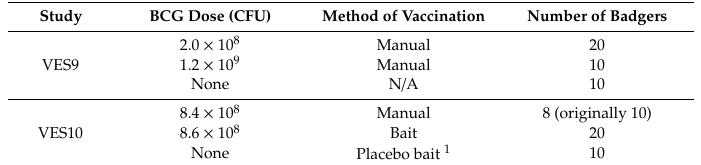
Table 2. Details of treatment groups in the two experiments: mean vaccine doses and method of vaccination.